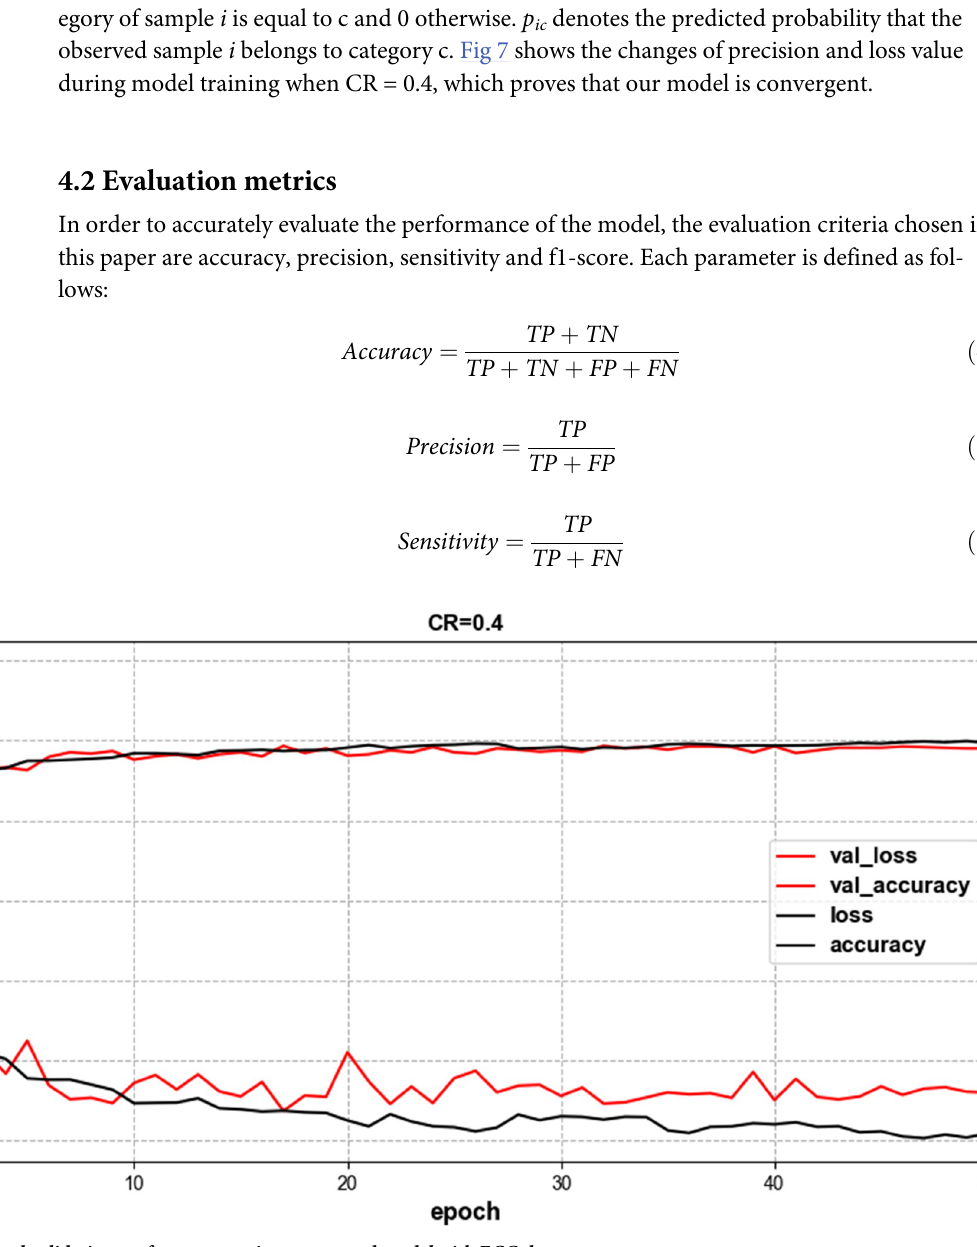
Fig 7. Training and validation performances using a proposed model with ECG datasets.